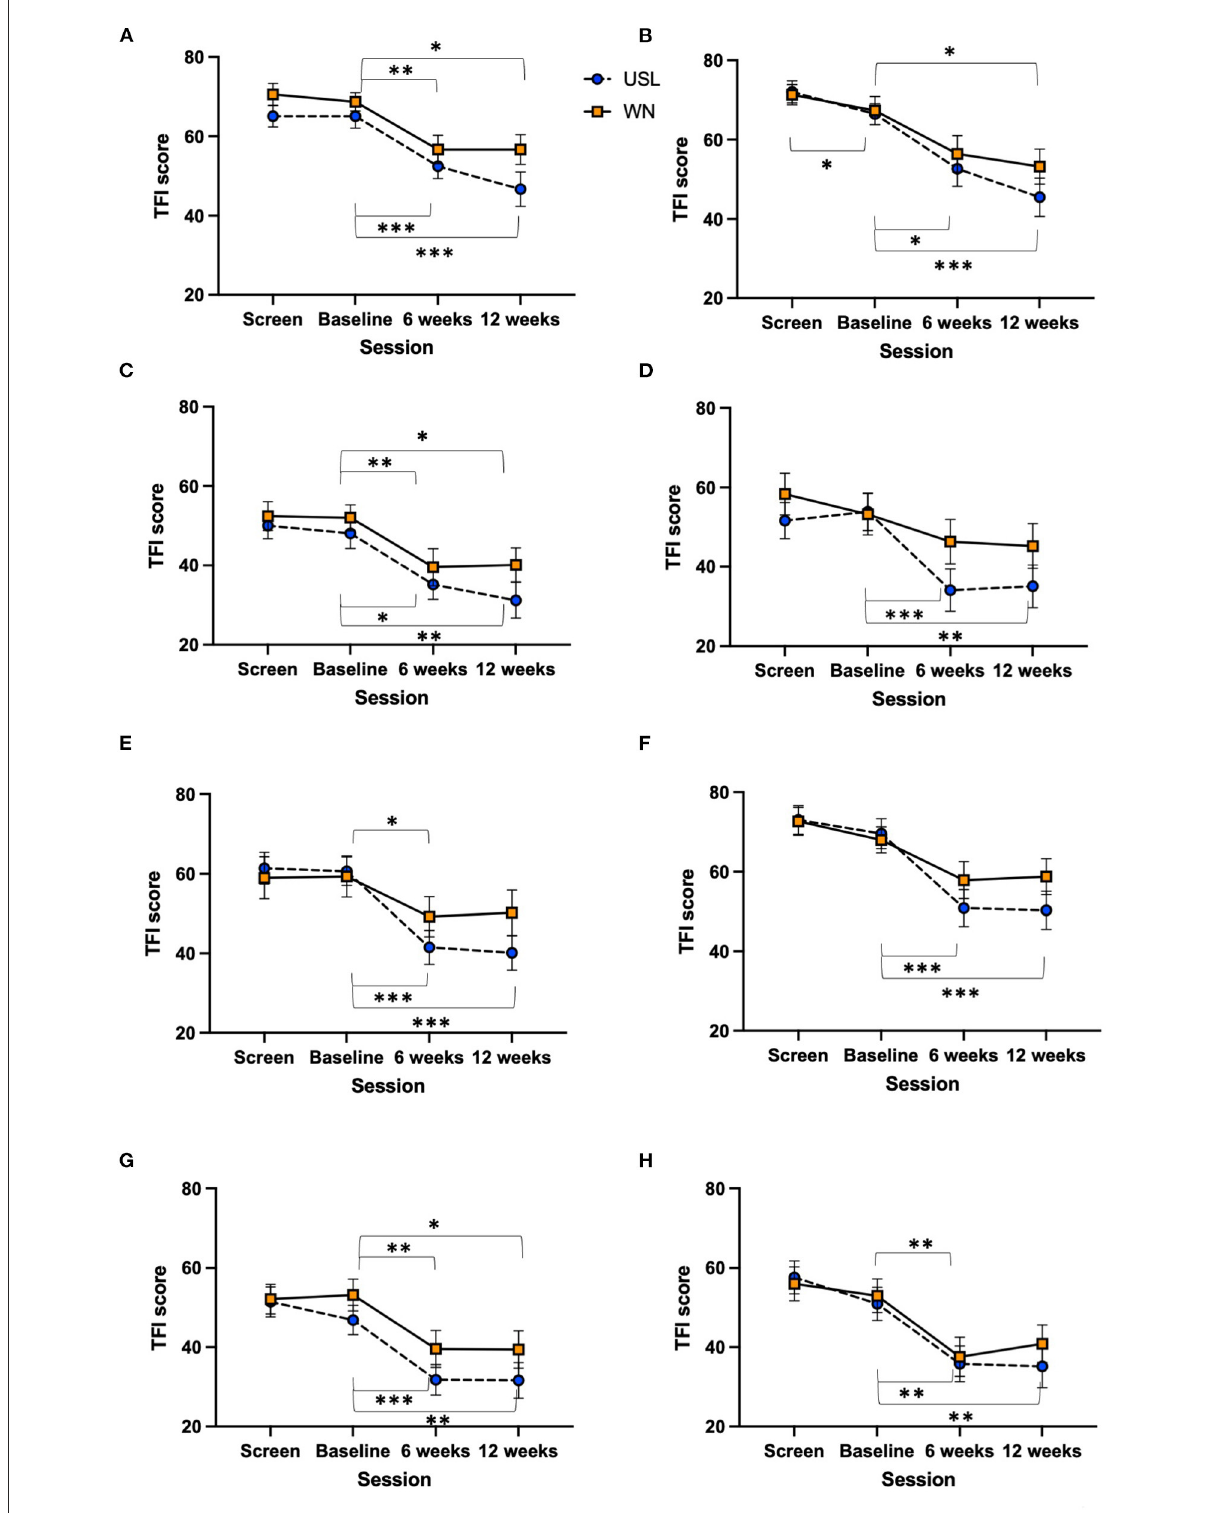
FIGURE6 TFI subscale scores across sessions. (A) Intrusive, (B) control, (C) cognitive, (D) sleep, (E) auditory, (F) relaxation, (G) quality of life, and (H) emotional distress. USL group (dashed line) WN group (solid line) ( * P < 0.05, ** P < 0.01, *** P < 0.001). Mean scores and standard error bars are